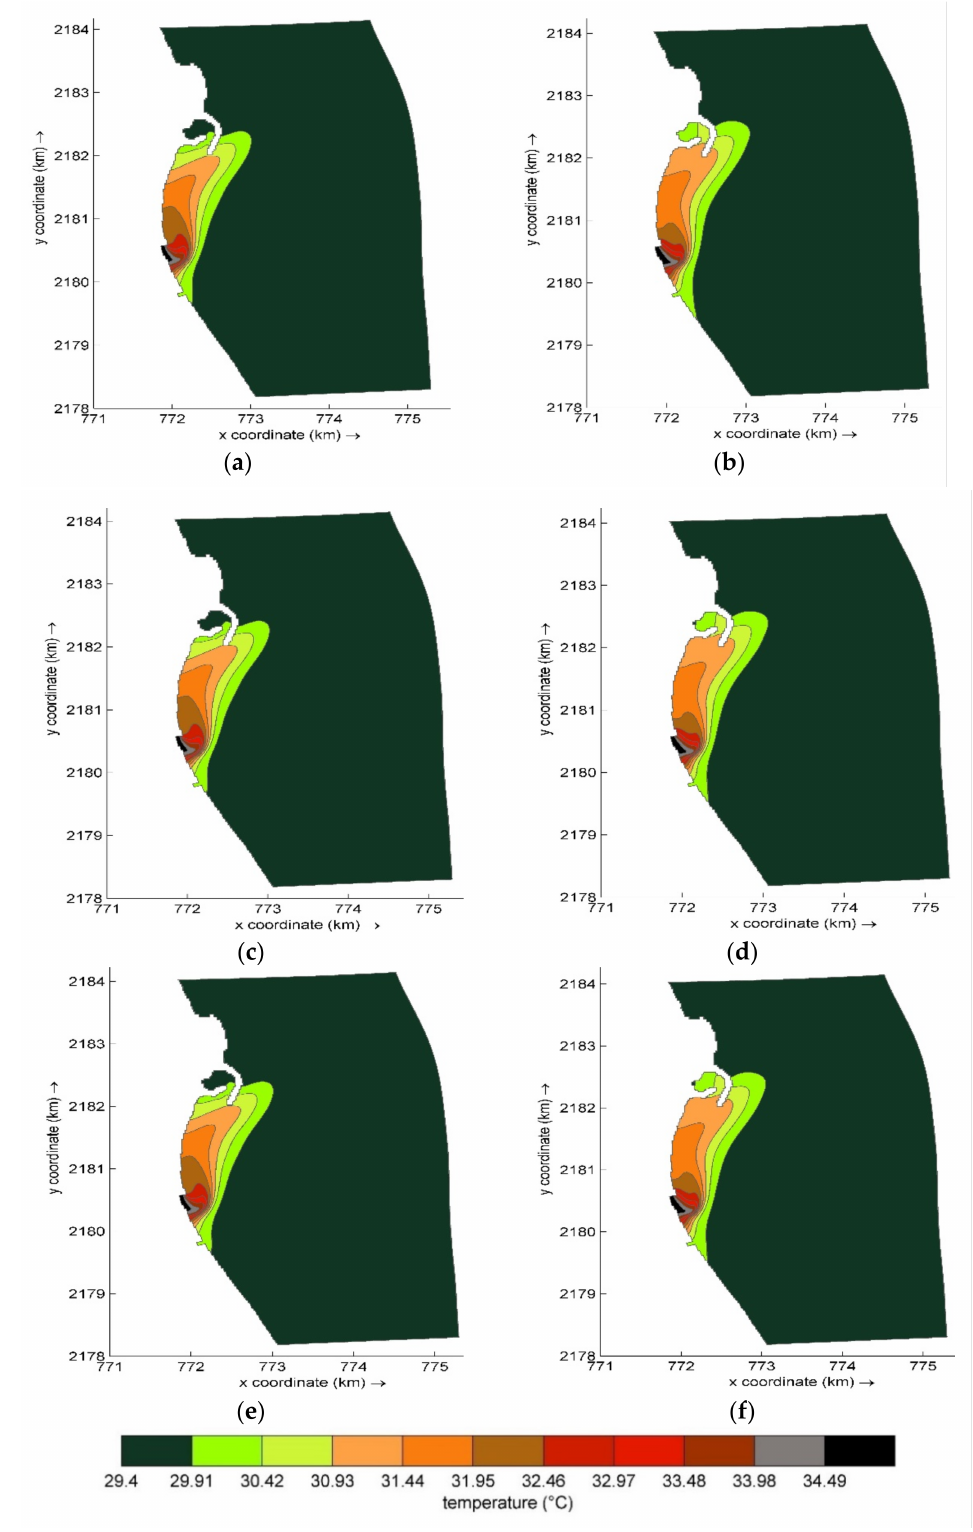
Figure 11. Comparison of the free surface temperature at 10:45:00 on 17 May 2017 with several turbulence closure models: ( a ) AEM with HLES; ( b ) AEM without HLES; ( c ) k − ε with HLES; ( d ) k − ε without HLES; ( e ) k − L with HLES; ( f ) k − L without